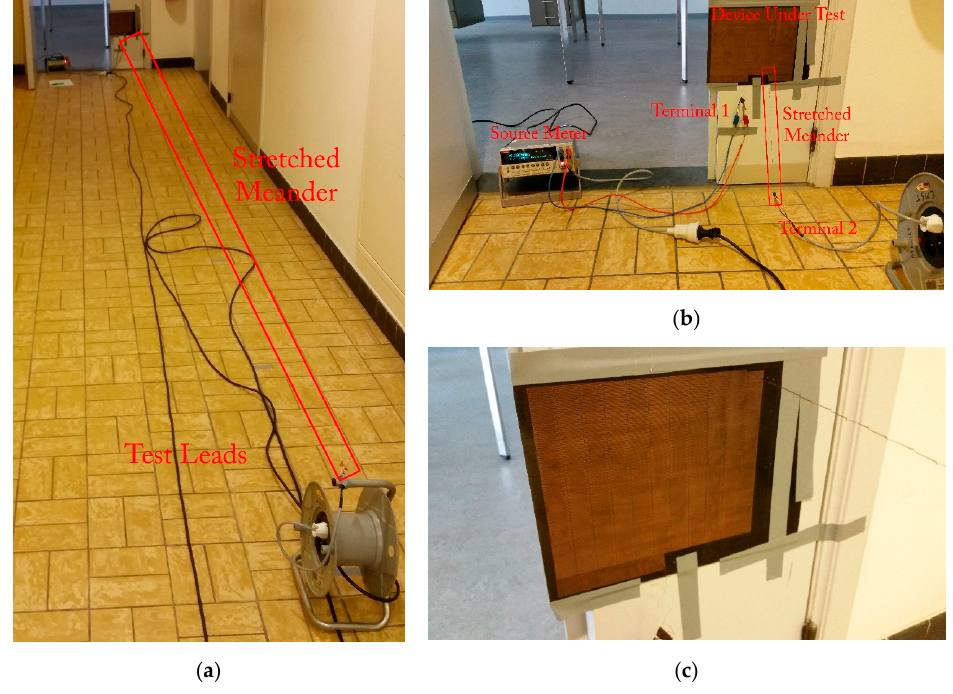
Figure 3. Measurement setup used to determine the meander resistance as a function of the extension: ( a ) measurement setup at the 10 m extension mark; ( b ) measurement setup at the start of the measurement before any extension. The cable reel visible at the bottom right of the image was used to extend the test leads to the desired length; ( c ) detailed view of the carrier board and circuit at the 10 m extension mark.